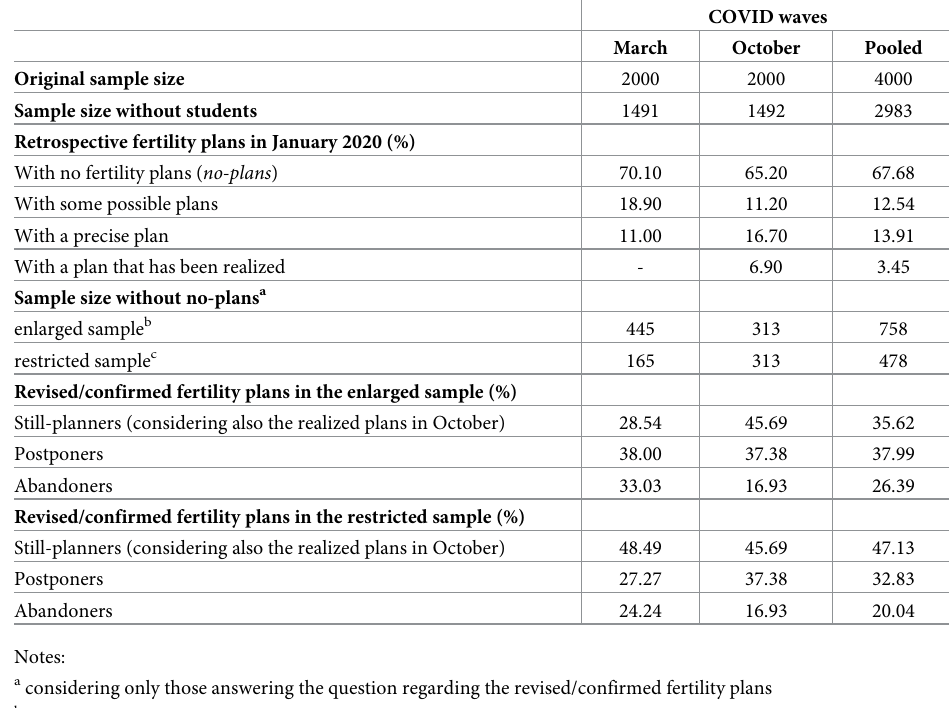
Table 2. Samples’ size and distribution of the dependent variables, main covariates and control variables for the COVID waves (March and October 2020); separated and pooled